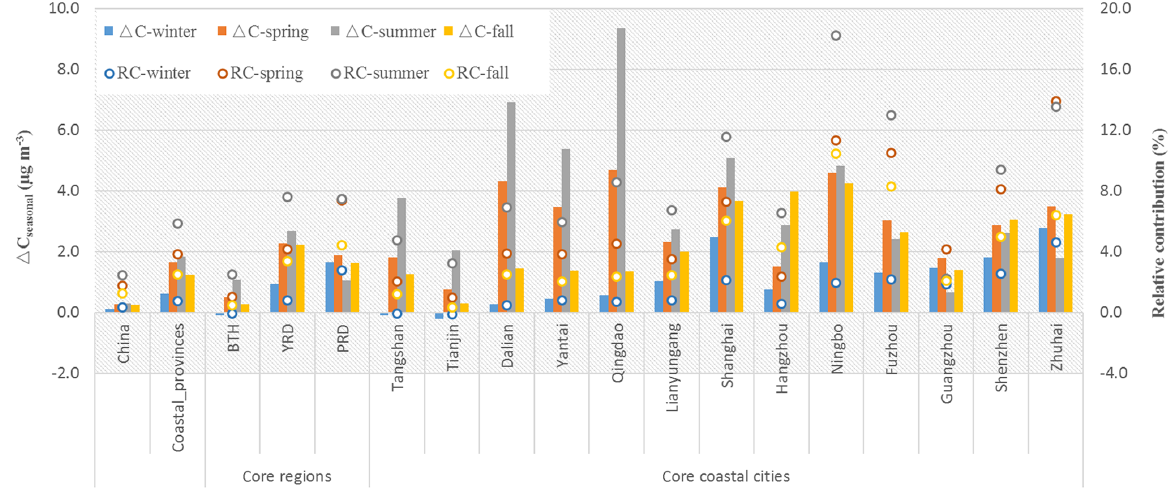
Figure 6. Contributions of shipping emissions to the seasonal PM 2 . 5 in core coastal regions and cities (base case – no ship